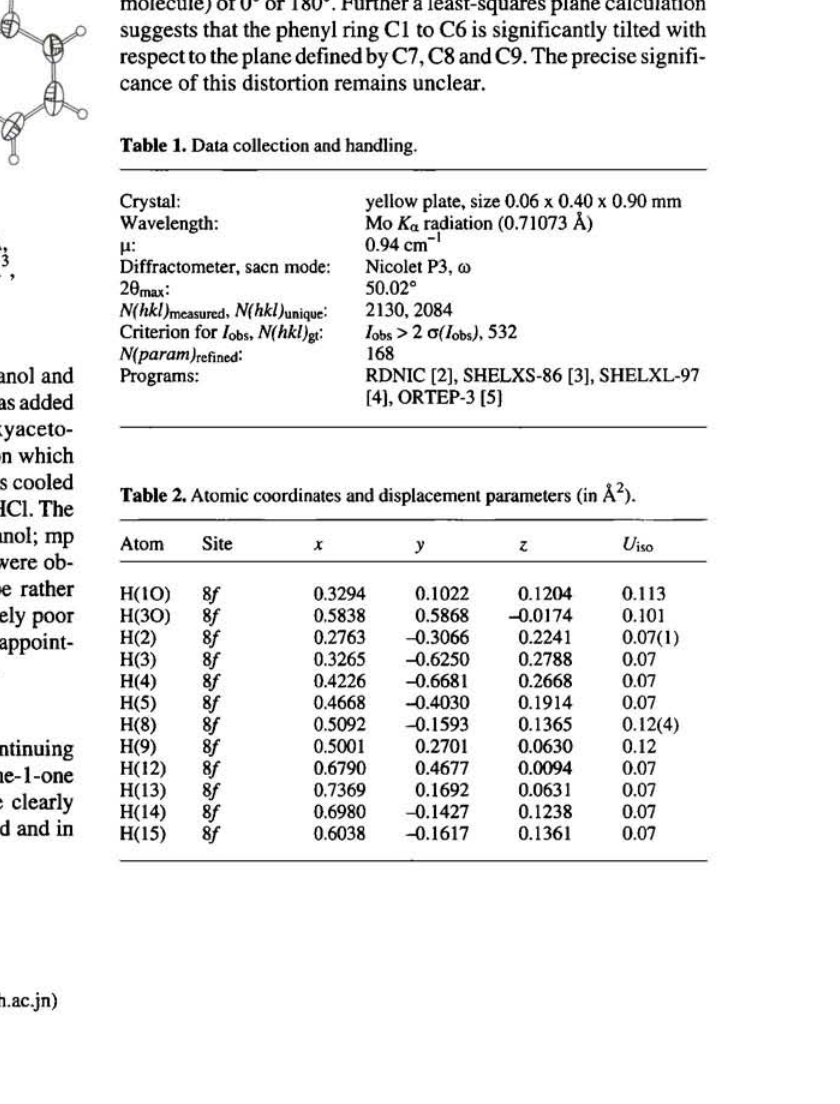
Table 1. Data collection and handling. Crystal: